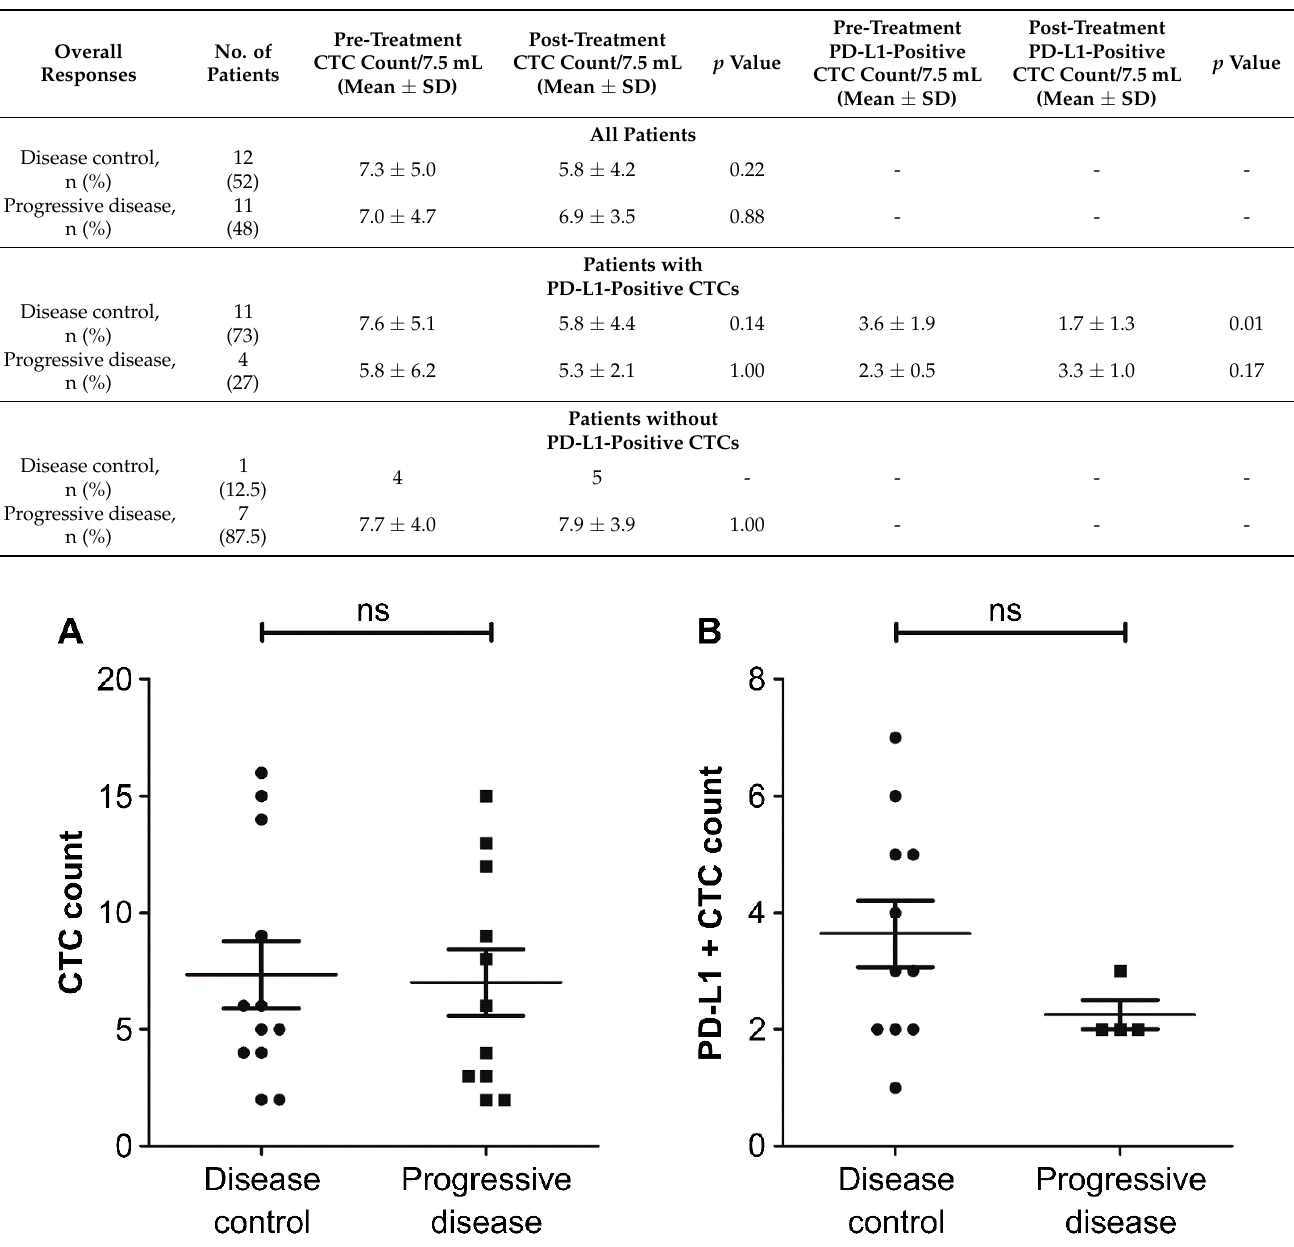
Table 3. Circulating tumor cell (CTC) count and overall response rates to programmed cell death ligand 1 (PD-L1) blockade therapy.